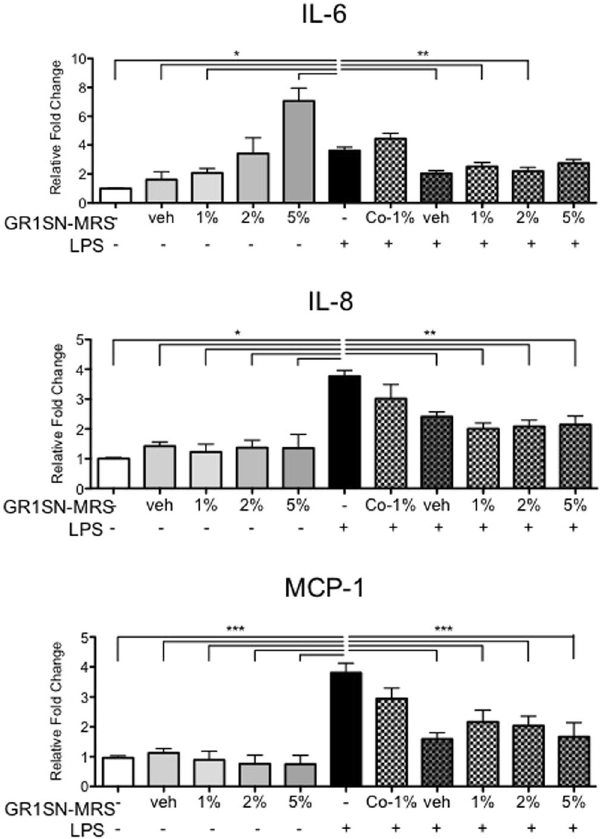
Figure 2. Effect of GR1SN-MRS treatment on hTERT-HM cell cytokine secretion following LPS stimulus. hTERT-HM cells were treated with MRS broth (1% v/v) or various doses of GR1SN-MRS (1, 2, 5% v/v) without LPS stimulus (solid grey bars), for 16 hours prior to (checkered grey bars), or concurrently with (GR1SN-MRS 1%, v/v, “Co-1%”) LPS (100 ng/mL). Values are presented as fold change (mean ± SEM) relative to untreated control (solid white bars). Statistical significance was determined by One-way ANOVA followed by Dunnett’s post-test relative to LPS stimulus (solid black bar). * P < 0.05; ** P < 0.01; *** P < 0.001 (n =